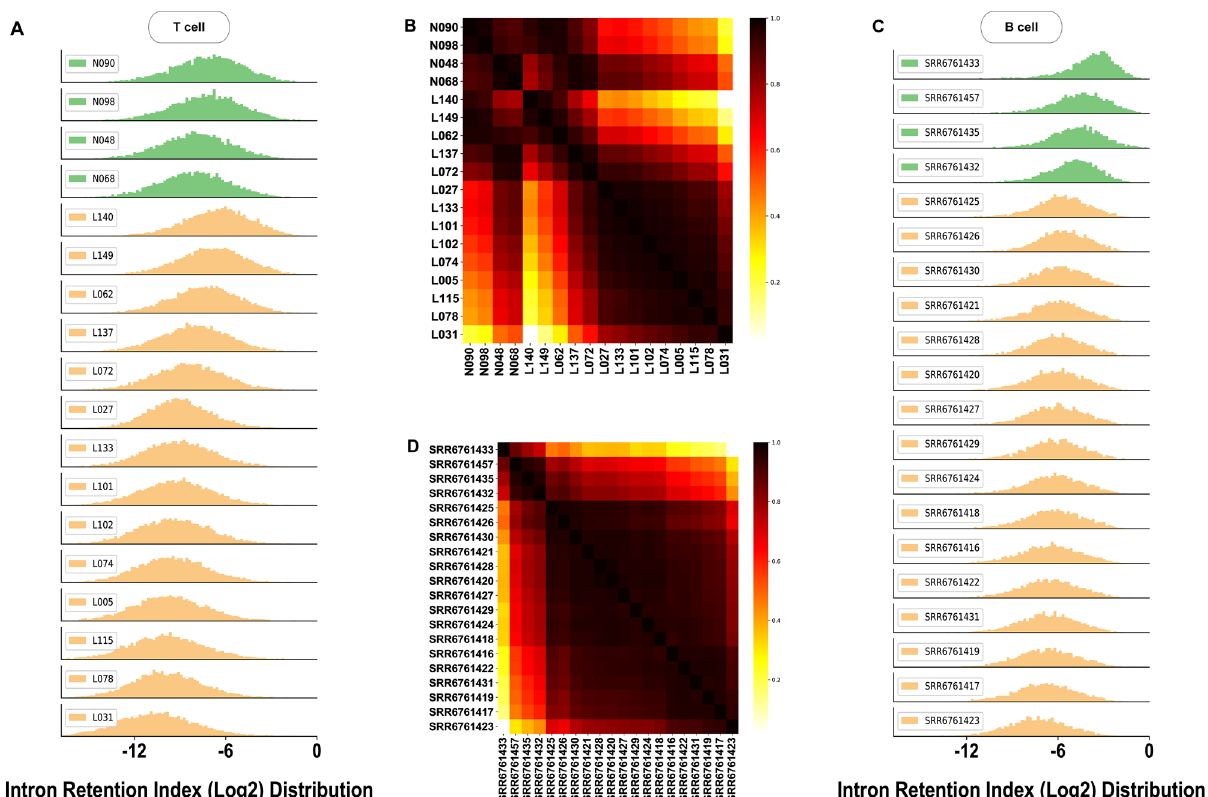
Figure 1. Intron retention index (IRI) in T and B cells. ( A ) The density distribution of IRI from all 18 T-cell samples including 4 control samples (green) and 14 SLE patients (gold). ( B ) Heatmap of pairwise Pearson’s correlation coefficient matrix of IRI distributions shown in ( A ). There appeared to be two major diagonal blocks separated around L137 with a majority of SLE patients forming the lower block. ( C ) The density distribution of IRI of all 20 B-cell samples, including 4 control samples (green) and 16 SLE patients (gold). Note that the B cell samples were obtained from a cohort different from that for T cells in ( A ) above. Namely, T-cell and B-cell samples were not from the same cohort. ( D ) Heatmap of pairwise Pearson’s correlation coefficient matrix of IRI distributions shown in ( C ). The lower diagonal block formed by SLE patient samples was clearly separated from the upper block formed by control normal or even enhanced. SLEDAI scores were quite high, 20 and 16, on L149 and L137, respectively. L149 and L140 were the only two male patients. Mean distributions of control and SLE IRI distributions can be found in Fig. S3A with p-value equals to 0.079 using Mann–Whitney U test. Since dysregulation of B cell function is believed to be associated with SLE pathogenesis 44 , sample stratifica- tion using IRIs was also carried out in sorted B cells from an independent cohort of SLE patients. Figure 1C shows the histograms of IRI distribution for each sample obtained from 3621 genes with IRIs detectable in all 20 samples (4 control samples and 16 SLE patient samples). A similar global shift toward reduced IRI levels was also observed in SLE B cells (Fig. S2 and Table S3), supported by distinguished mean distributions (Fig. S3B) ( p value = 0.0004 using Mann–Whitney U test) of control and SLE IRI distributions. Based on the pairwise Pearson’s correlation coefficients between two IRI distributions in Fig. 1D, the 20 samples were clearly divided into two blocks, 4 control samples in one block and 16 SLE samples in the other block. Interestingly, in contrast to the pattern of two distinct SLE subgroups based on IRIs of T cells, B cells in all SLE patients showed a remarkably converged pattern centered around a mean value of Log2(IRI) = − 5.2, which was decreased from a value of Log2(IRI) = − 3.9 for the control samples. Weak and negative correlation between fold changes in gene expression and intron retention index in T and B cells. Given that the observed large-scale IR modifications above and the previously reported gene expression anomaly 45,46 were both associated with SLE pathogenesis, it is natural to examine the relation between IR and gene expression. As a quantitative measure, we computed the fold change defined as the ratio of the mean value of either IRI or gene expression level between SLE patients and the controls. Figure 2A and B clearly showed a weak but significant correlation between IRIs and gene expression levels in T cells as confirmed by the negative Pearson’s correlation coefficient (r = − 0.34, p < 5E-200). As further illustrated by the case of a specific gene, i.e., interferon regulated factor 7 (IRF7), up-regulated expression of IRF7 in SLE patients (relative to the controls) was accompanied by a down-regulated IRI of the IRF7 transcript as shown in Fig. 2C. This pattern between IR and gene expression was consistent with the earlier results reported during in vitro